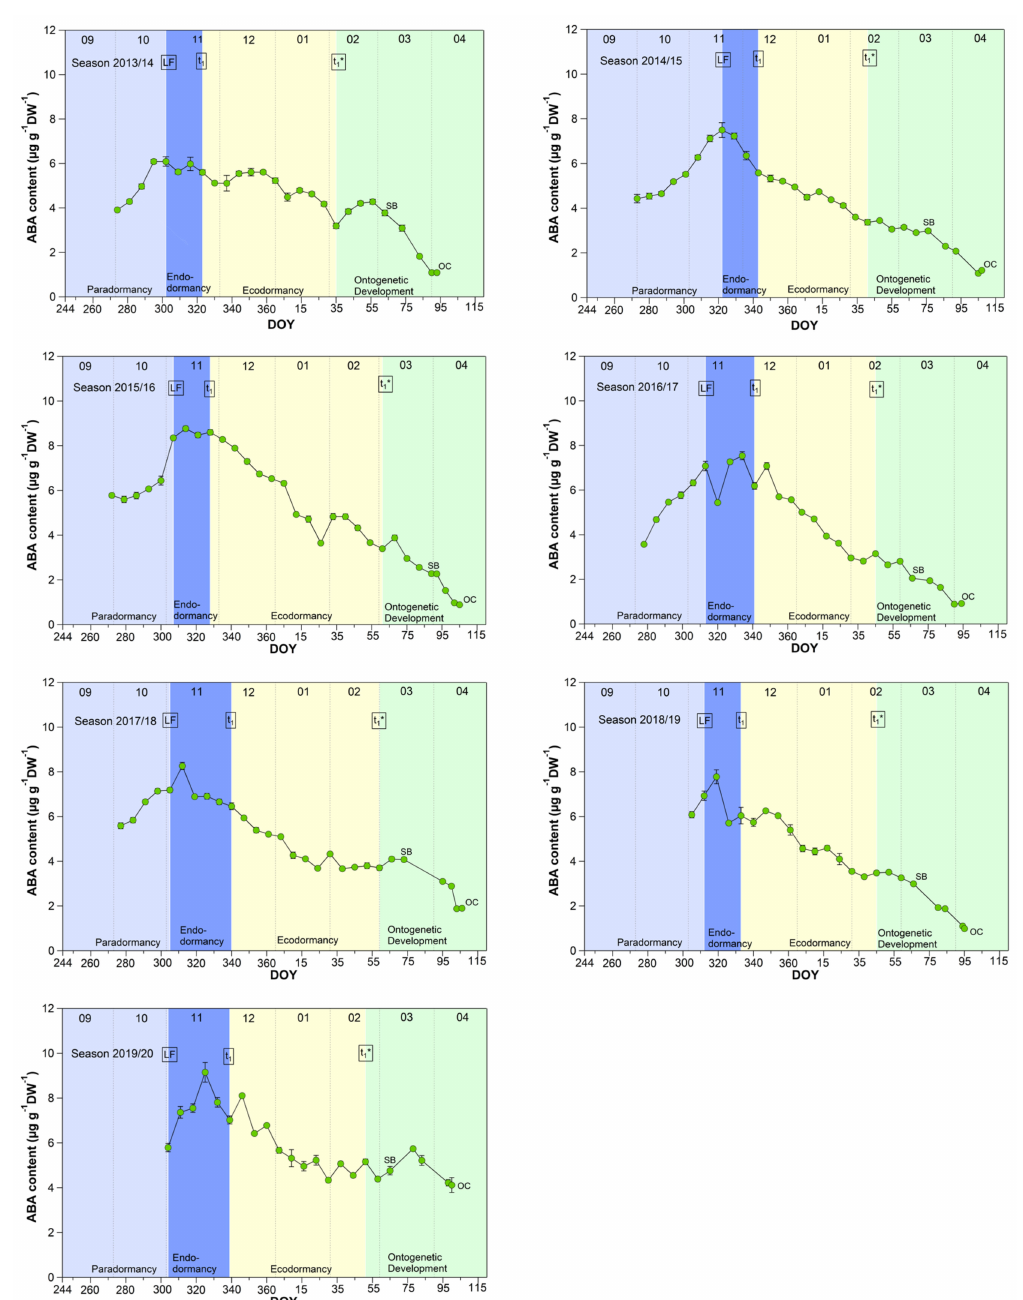
Figure 5. Abscisic acid in sweet cherry buds cv. Summit, 2011/12–2019/20. ‘Total leaf fall’ (LF), endodormancy release (t 1 ), beginning of ontogenetic development (t 1 *), ‘swollen bud’ (SB) and